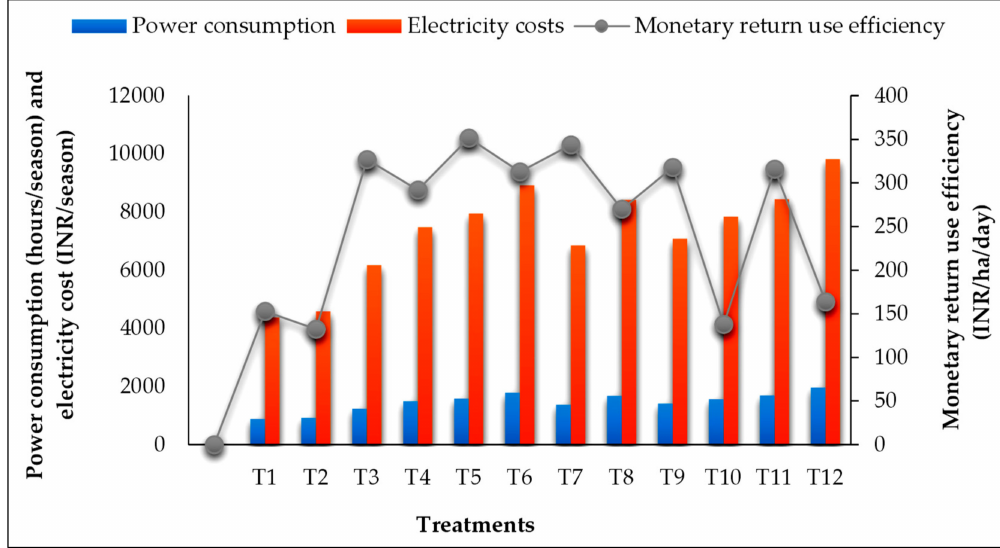
Figure 2. Power consumption, electricity cost, and monetary return use efficiency of experimental